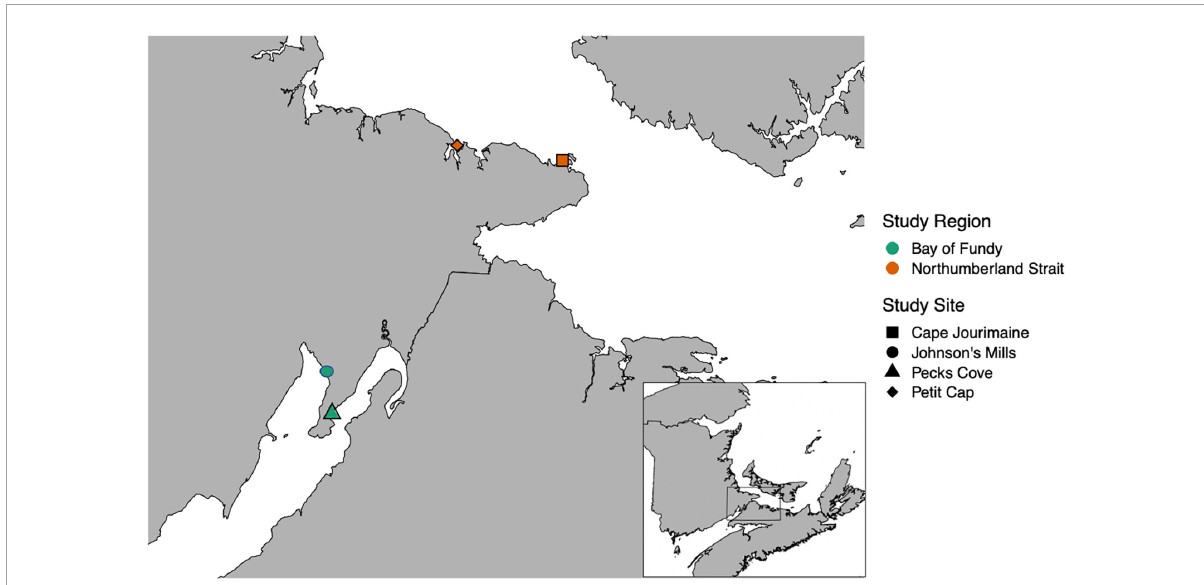
FIGURE1 Map of study sites in both regions: the Northumberland Strait (orange), and the Bay of Fundy (green). Semipalmated Sandpiper captures occurred at Johnson’s Mills (adjacent to Grand Anse) (green circle) and Petit Cap (orange diamond). Habitat transects were completed at all four sites in 2019. In 2018 Cape Jourimain was not